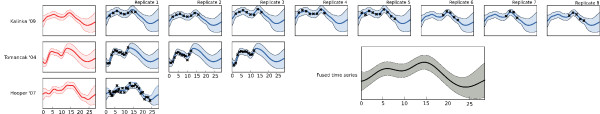
Hierarchical GP regression on across three data sets, for the gene Acer. Each data set is represented by one row, and each replicate within a data set is represented by a single pane in that row. Shaded regions represent 95% confidence intervals. Inset: the fused time-series. (Y-scales removed for clarity but are consistent between plots).